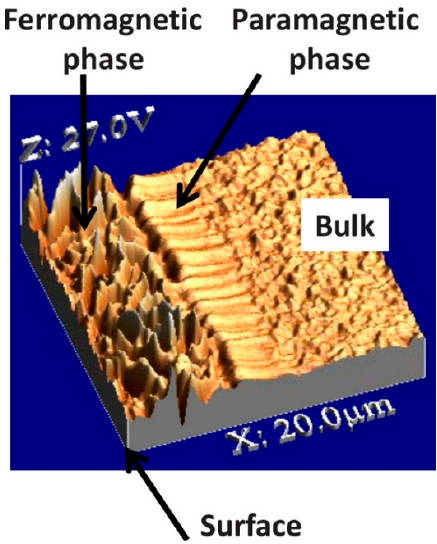
Figure 10. 3-D MFM image of an AISI 316 ion beam nitrided (380 ◦ C, 2 h) sample. The peaks in the outer layer represent the magnetic domains of the ferromagnetic phase. For further details, see [250]. (Reprinted from Journal of Applied Physics 105 (2009), R.L.O. Basso, V.L. Pimentel, S. Weber, G. Marcos, G, T Czerwiec, I.J.R. Baumvol, C.A. Figueroa, Magnetic and structural properties of ion